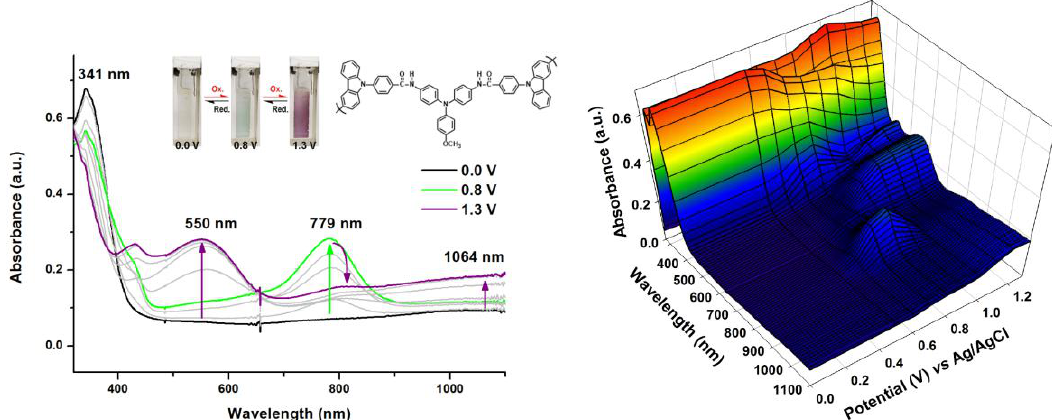
Figure 9. Spectroelectrochemistry of the electro-generated films of P1 (thickness: 250 ± 100 nm) on